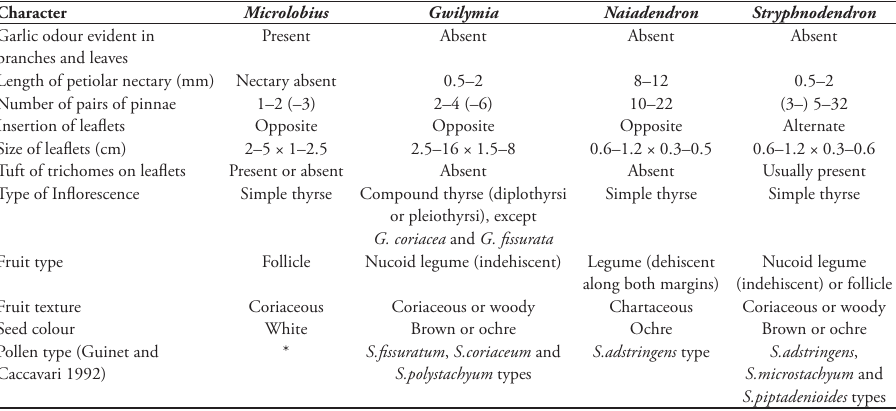
Table 1. Diagnostic characters of the four Stryphnodendroid lineages. * Microlobius was not sampled in Guinet and Caccavari 1992; a description provided in a later work includes its single species (Caccavari 2002) which suggests that the genus might have its own distinct pollen